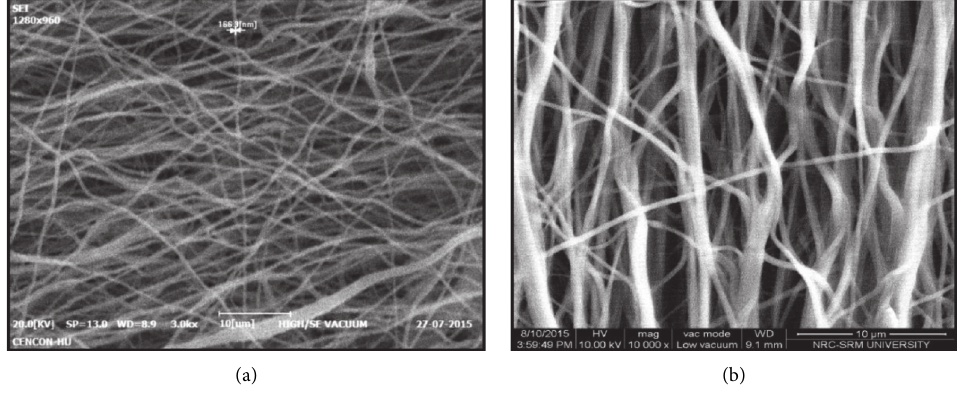
Figure 2: SEM image of (a) CNF and (b) CNT dispersed